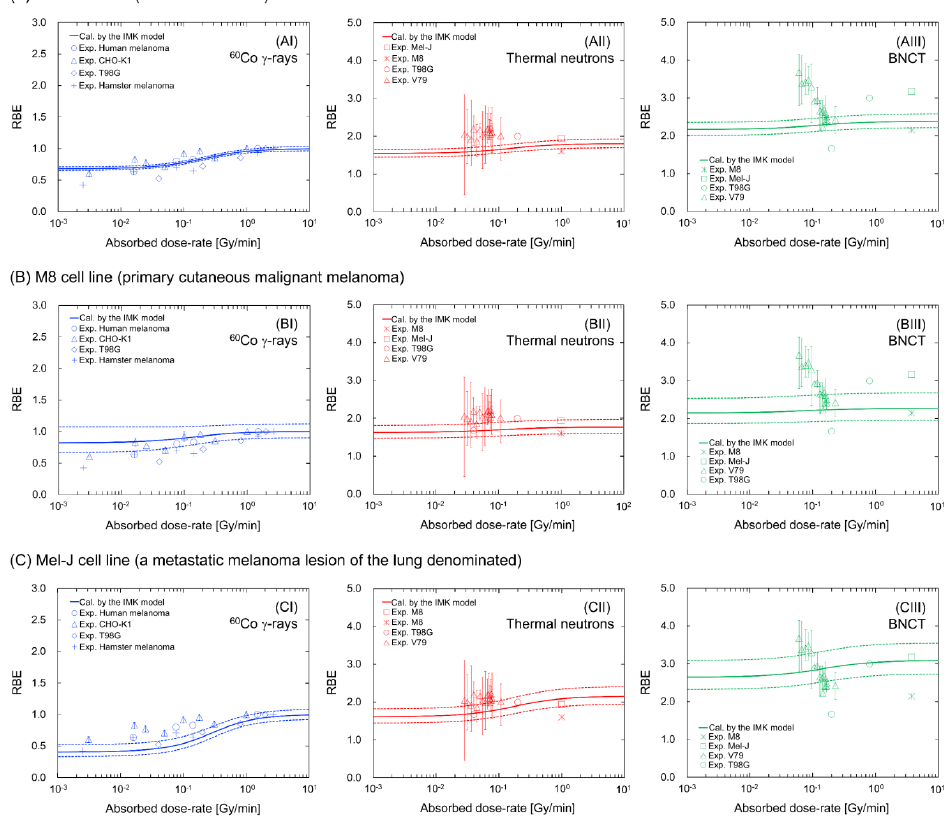
Figure 5. Estimation of dose-rate effects on RBE values for 60 Co g-rays, neutron only and BNCT in the presence of 10 ppm BPA labeled with 10 B for the ( A ) HX34 cell line, ( B ) M8 cell line and ( C ) Mel-J cell line. For the BNCT irradiation, we assumed that 10 B concentrations in cells are constant. The solid and dotted lines represent the mean value and 68% confidence intervals, respectively, which are calculated by MCMC sampling. The symbols represent the experimental data obtained from the literature [25,33,39,45,56–58].